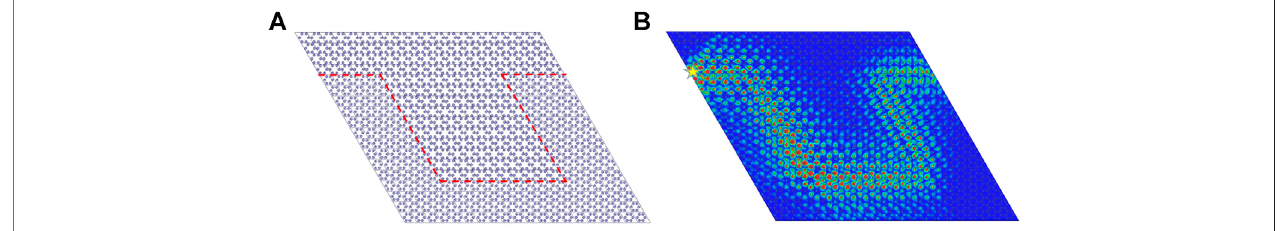
FIGURE 4 | (A) Two-dimensional sharp bend structure consists of topologically non-trivial and trivial lattices. The upper part of the red line is the topologically non- trivial lattices, and the lower part of the red line is the topologically trivial lattices. (B) Electric fi eld distribution of the sharp bend structure at 5.7 GHz. The yellow star indicates the excitation source, and the color indicates the electric fi eld intensity.